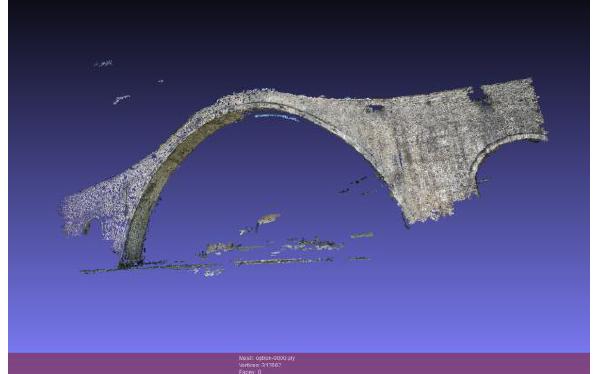
Figure 7: Dense point cloud after PMVS software (VisualSfM) – 51 images.